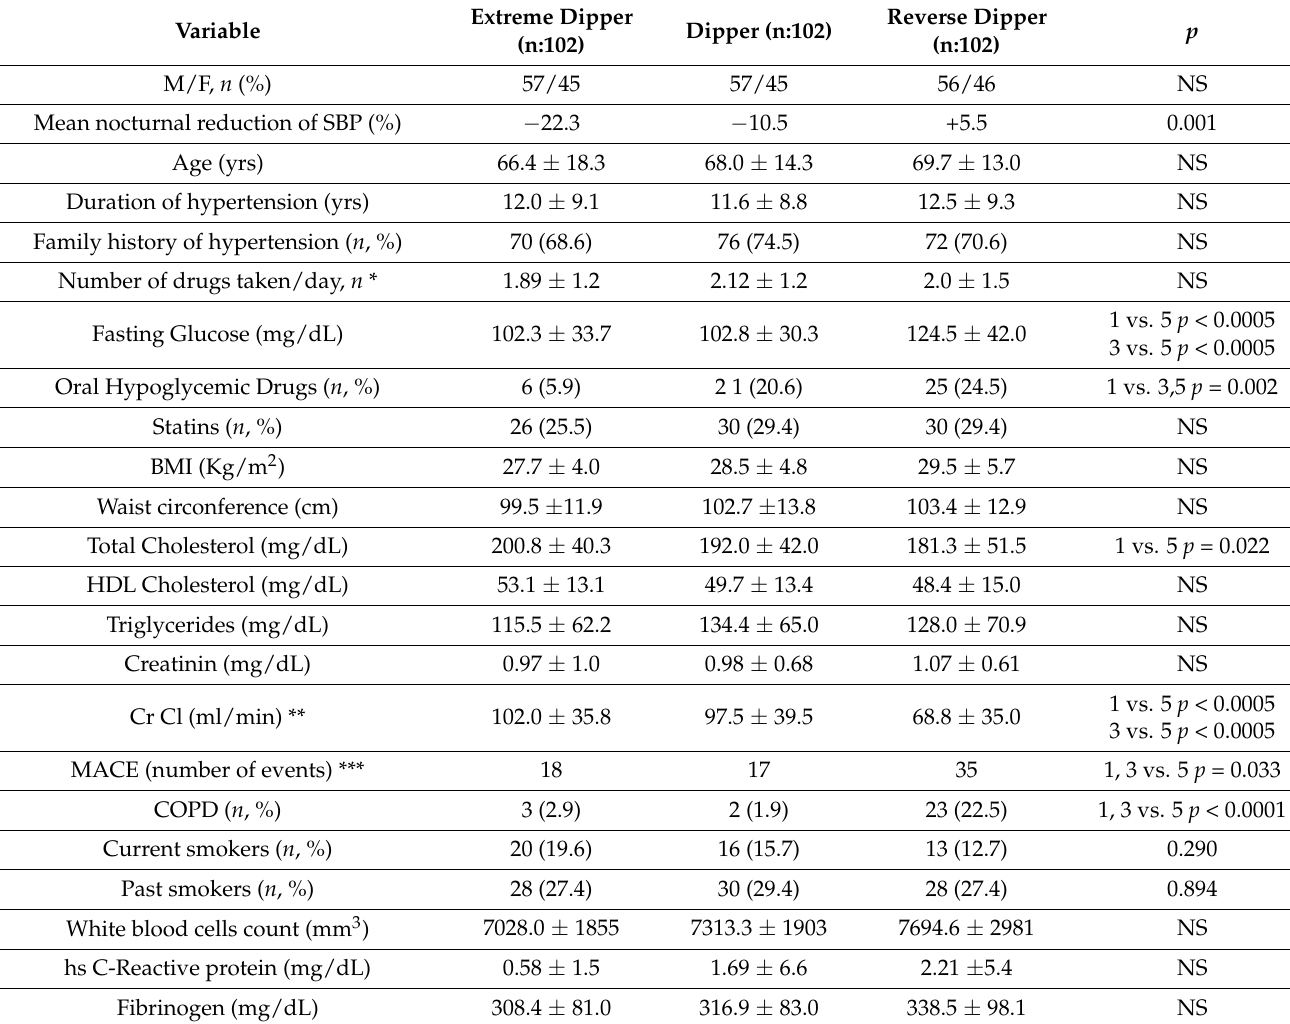
Table 1—Data are presented as mean value ± DS. BMI means Body Mass Index; Cr Cl: Creatinin Clearance; hsC C-Reactive Protein: High sensitivity C-Reactive Protein; SBP: Systolic Blood Pressure; MACE: Major Adverse Cardiovascular Event; COPD: Chronic Obstructive Pulmonary Disease, NS: Not Significant. * Antihypertensive drugs; the number of molecules and not the number of intakes were considered. ** Calculated applying the formula of Cockroft and Gault. *** MACE identifies the overall number of cardiovascular events (stroke, Table 2 shows the ABPM data. Reverse dipper hypertensives besides having